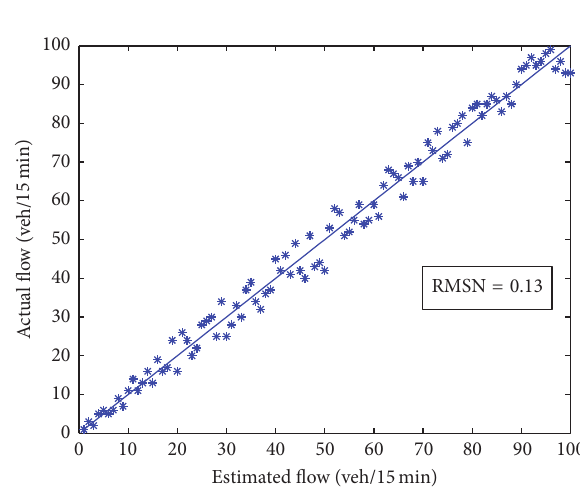
Figure 5: Comparison between surveillance flows and estimation flows.